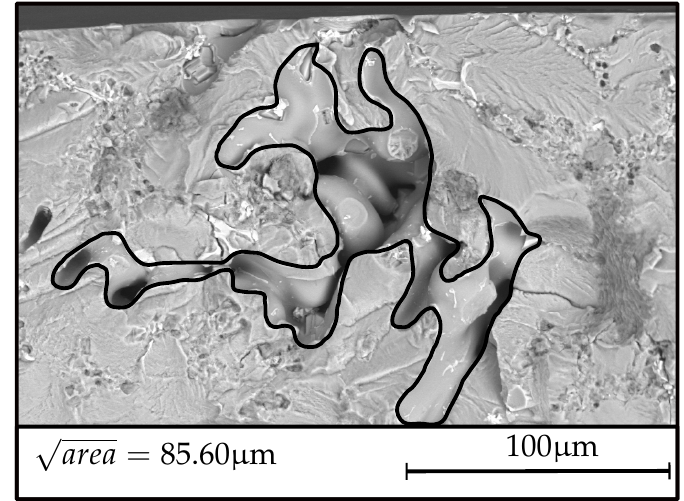
Figure 9. Representative fracture initiating defect at specimen geometry A.